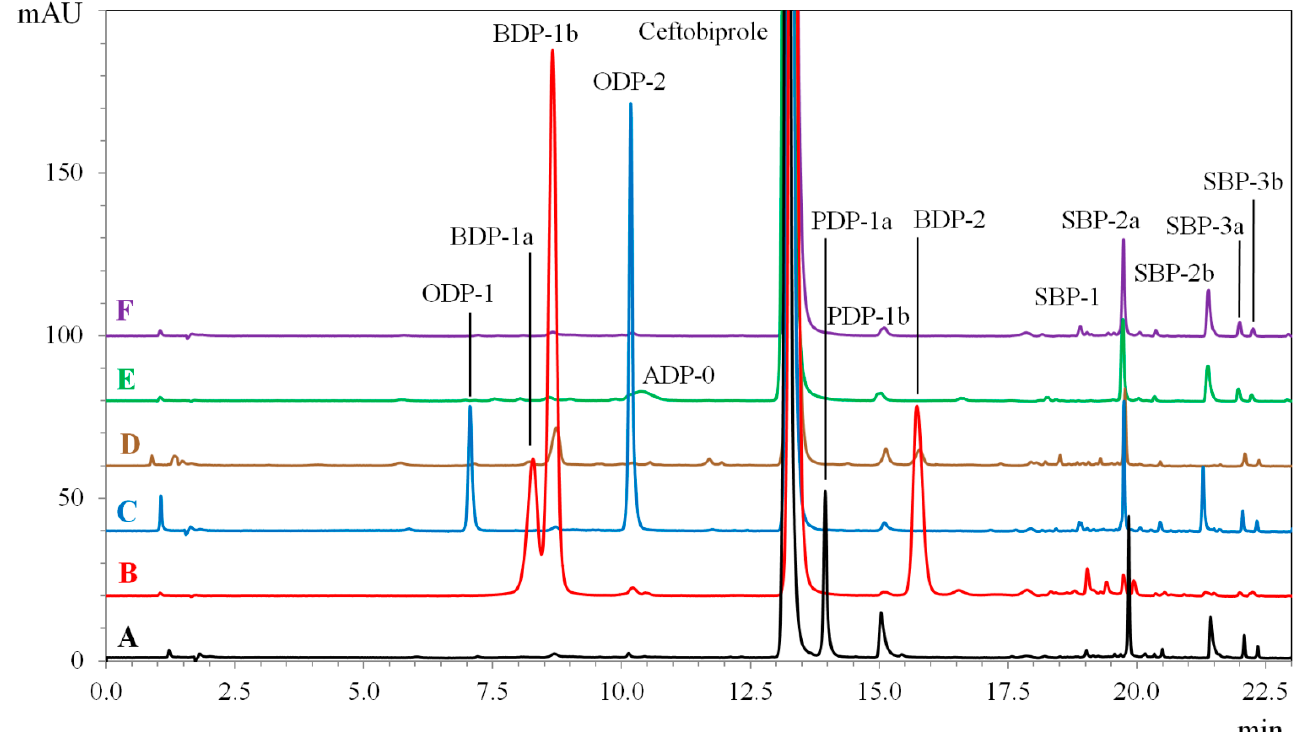
Figure 2. Overlaid chromatograms obtained by the separation of degradation products (DPs) of a 1 mg/mL ceftobiprole solution formed in different stress-testing studies: ( A ) photolysis for 6 h at 254 nm in 10% DMSO; ( B ) alkaline hydrolysis in 0.01 M NaOH for 45 min; ( C ) oxidation in 3% H 2 O 2 in 10% DMSO for 90 min; ( D ) thermolysis at 70 °C for 270 min in 10% DMSO; ( E ) acidic hydrolysis in 0.1 M HCl for 6 h; ( F ) non-degraded solution of ceftobiprole in 10% DMSO. The first letter of the acronyms describing the DPs comes from the degradation conditions under which they were ob- tained (A—acidic, B—basic, O—oxidative, P—photolytic), and the acronym SBP denotes synthesis by-products.